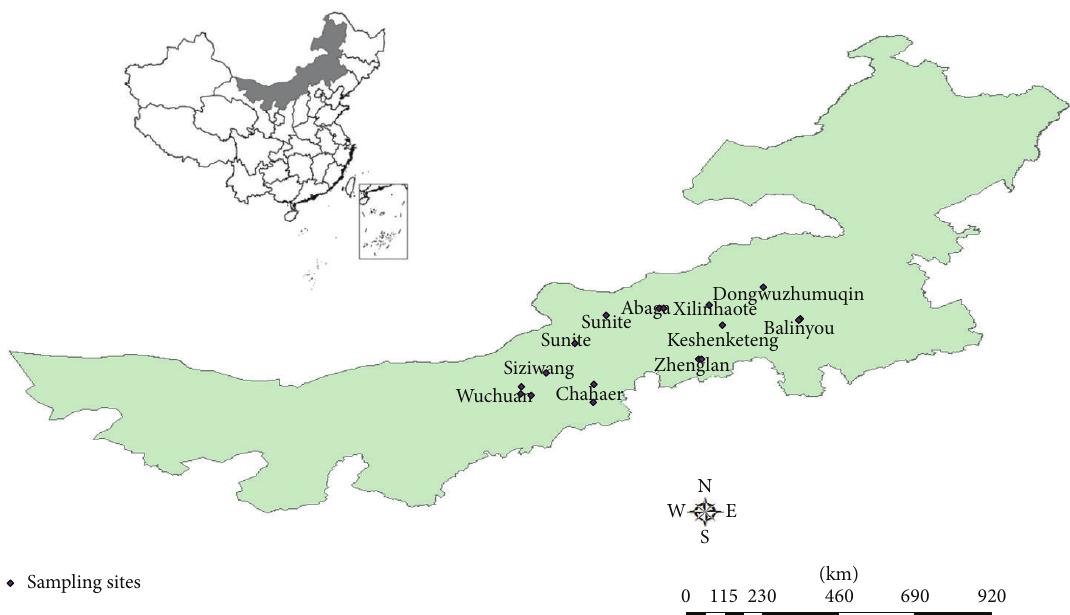
Figure 1: Study area and sampling sites in semiarid grassland, Inner Mongolia, China.